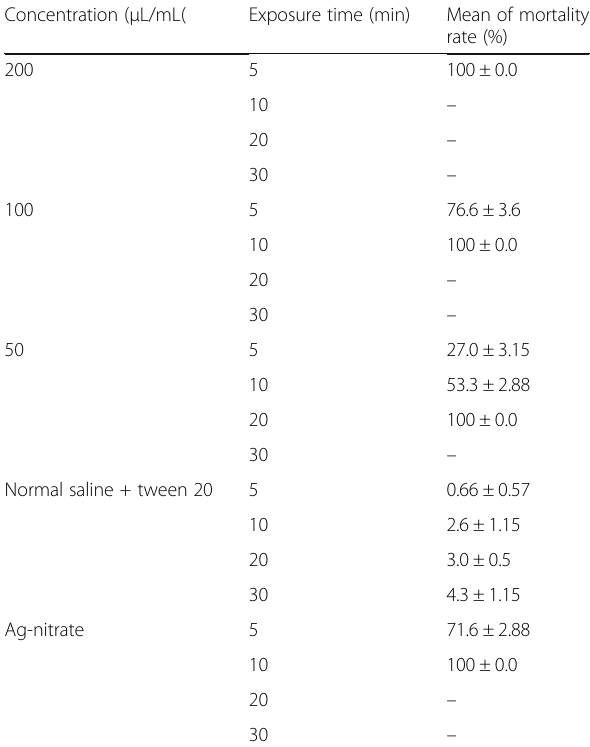
Table 2 In vitro protoscolicidal effects of C. longa essential oil against protoscoleces of hydatid cyst at various concentrations following various exposure times Concentration ( μ L/mL( Exposure time (min) Mean of mortality